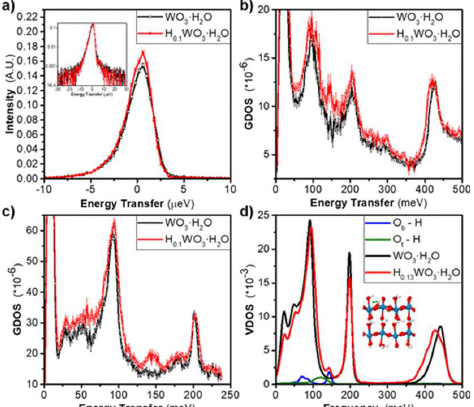
Fig. 12 . Confined interlayer water in tungsten oxide hydrates enables fast highly reversible proton intercalation. (a) QENS (BASIS) of an electrode in the pristine, WO 3 ·H 2 O, black, and intercalated, H 0.1 WO 3 ·H 2 O, red, states at T = 300 K. (b-c) INS (SEQUOIA) of the same electrodes at T = 5 K. (d) AIMD simulations of the vibrational density of states show the effect of protons at the terminal (O t , green) and bridging (O b , blue) oxygen atoms to the overall spectrum. Reprinted with permission from [79]. Copyright 2019 American Chemical